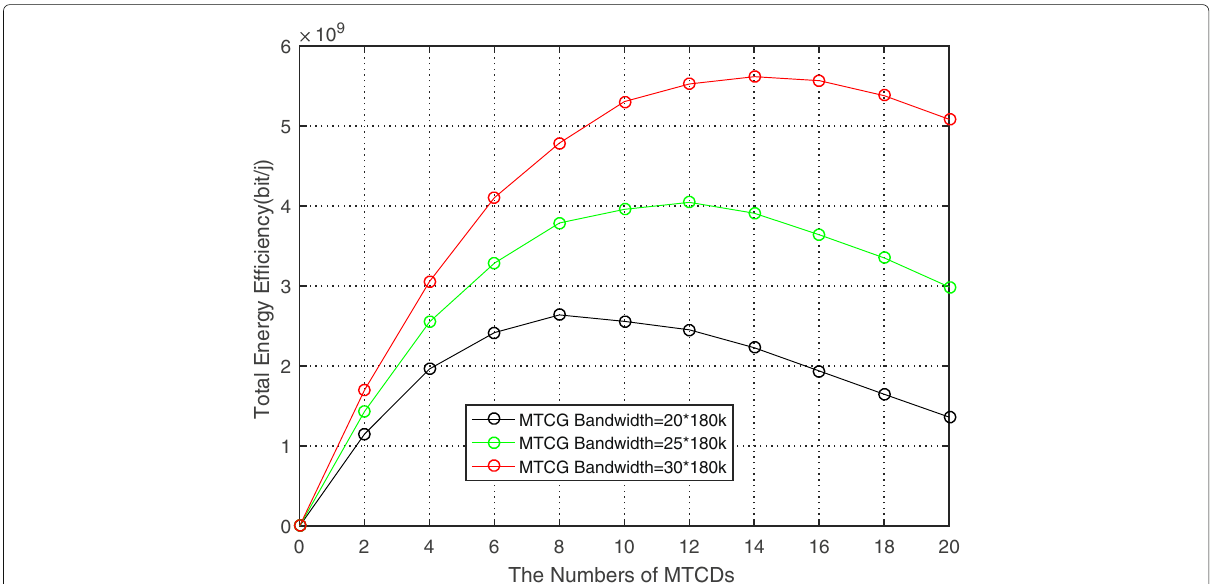
Fig. 6 The total energy efficiency with different numbers of MTCDs. The MTCDs are uniformly distributed in a 100-m radius of the MTCG, and the MTCG is uniformly distributed in a 1000-m radius of the BS. The payload of each MTCD is 1000 bit/TTI, and the self-interference of MTCG is (cid:3) = 1